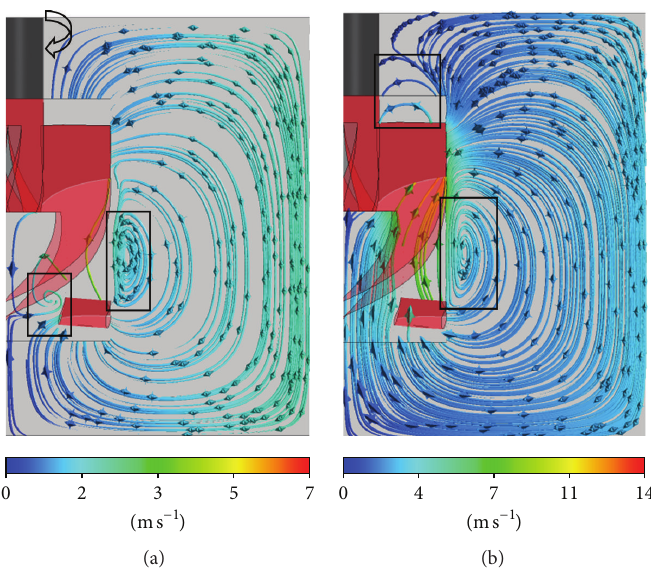
Figure 7: Velocity streamlines in 11% waste tissue pulp: (a) 𝑁 = 800 rpm and (b) 𝑁 = 1800 rpm.